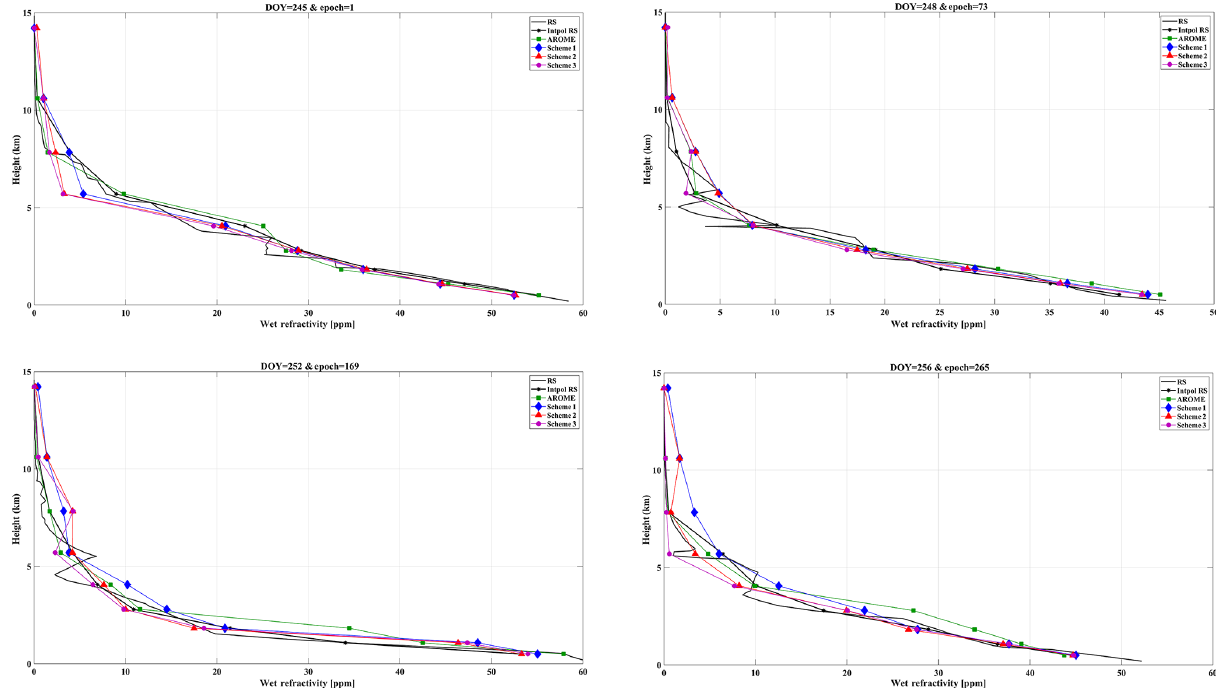
Figure 7. Comparison of wet refractivity profiles of different schemes to the profile derived from radiosonde data in DoYs (a) 245, (b) 248, (c) 252 and (d) 256 at first epoch (00:00UTC).